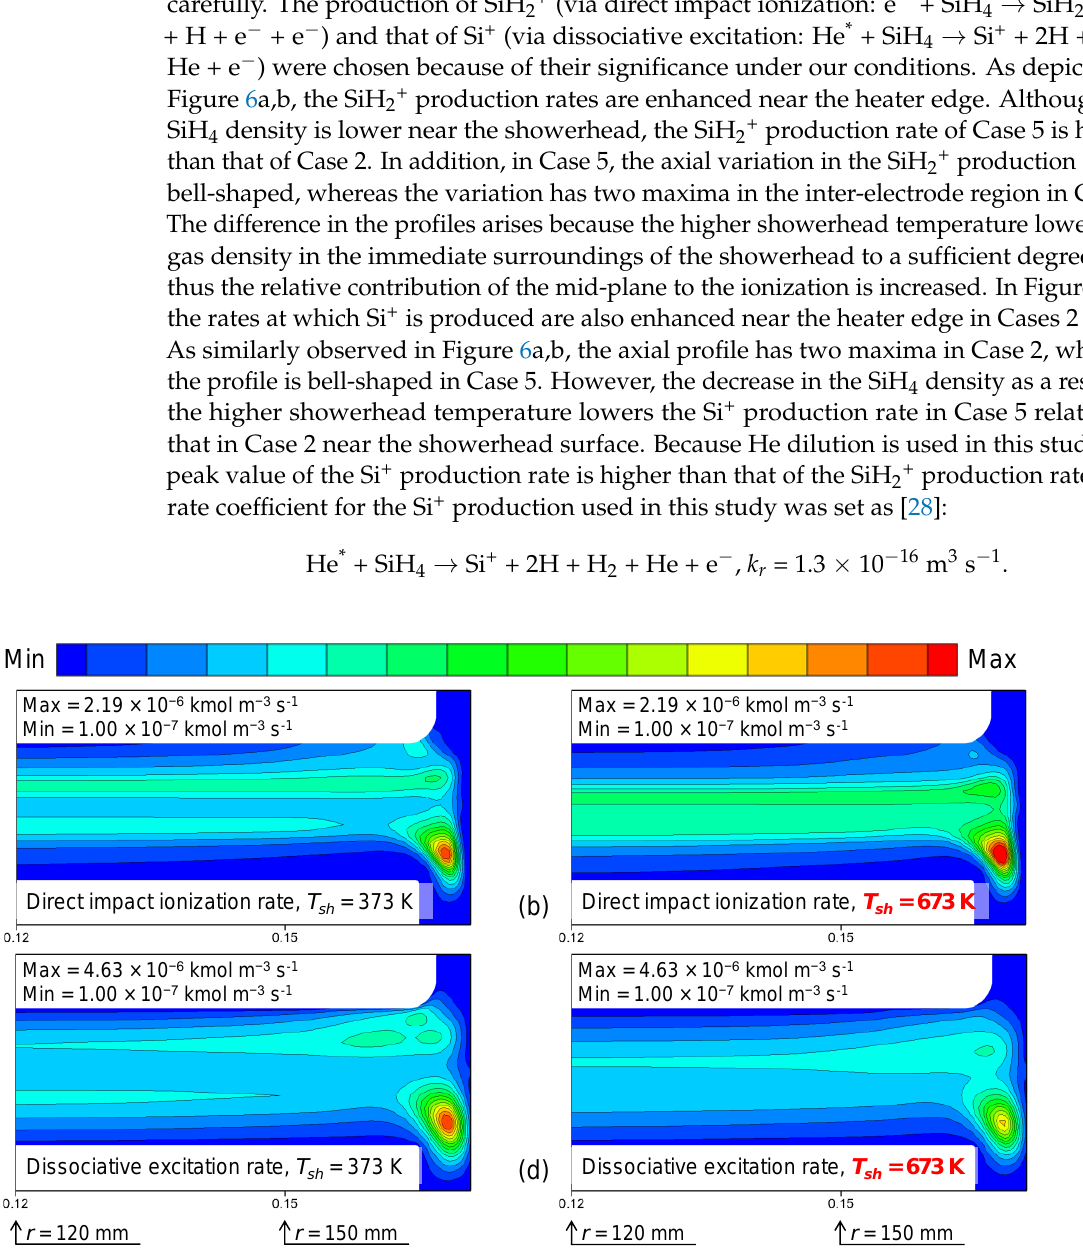
Figure 6. Effects of the showerhead temperature ( T sh ) on the spatial distribution of the plasma parameters. Contour plots for the spatial profiles of the time-averaged SiH 2+ production rate for ( a ) Case 2 ( T sh = 373 K) and ( b ) Case 5 ( T sh = 673 K) for r ≥ 120 mm. Contour plots for the spatial profiles of the time-averaged Si+ production rate ( c ) for Case 2 ( T sh = 373 K) and ( d ) for Case 5 ( T sh = 673 K) for r ≥ 120 mm. The profiles are radially uniform for r < 120 mm.